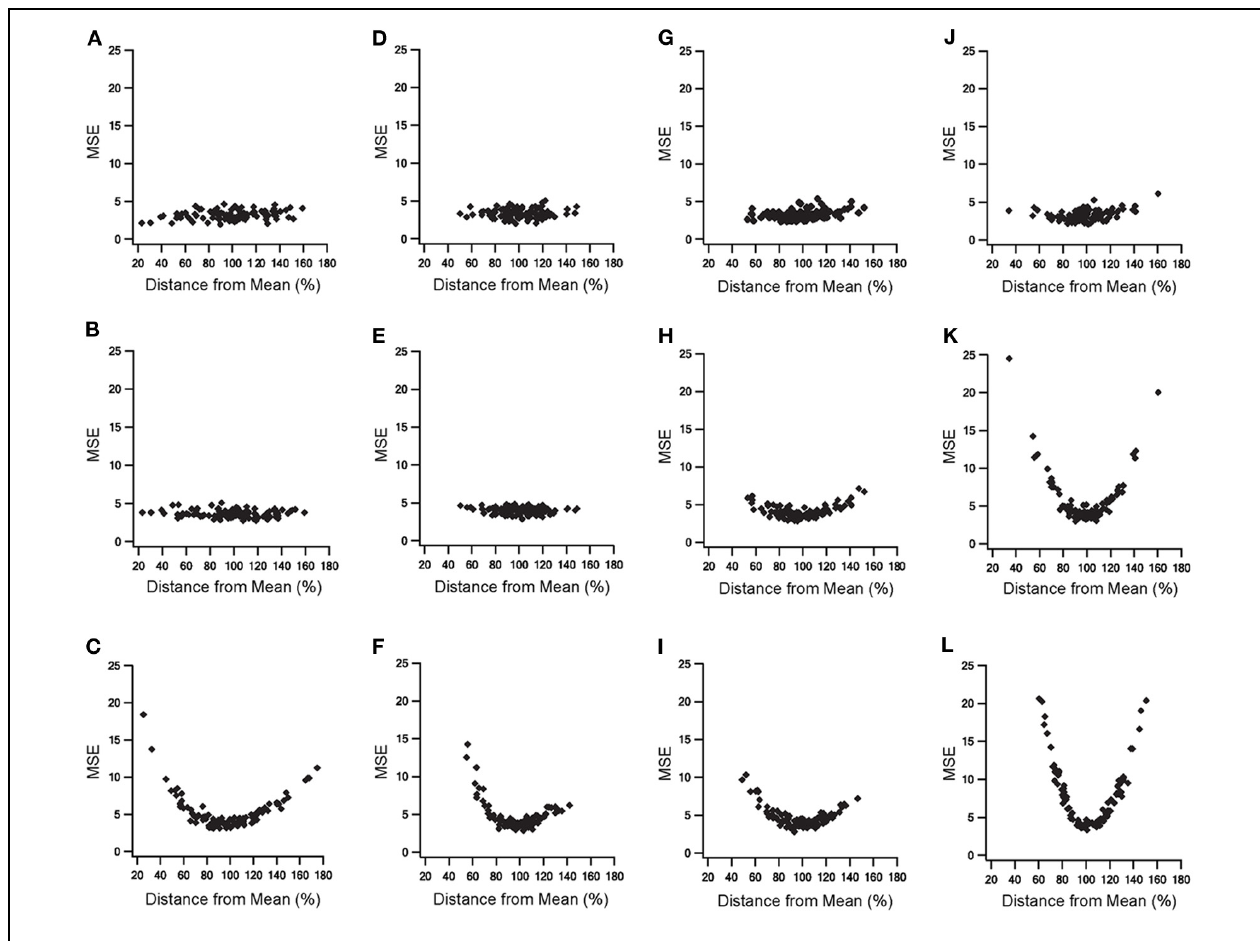
(D–F) , effects of changes in rate constant of decay reaction in metabotropic receptors (G–I) and effects of changing time constant of GP-GP depression (J–L) . Top row, errors during 10Hz stimulation; middle row, effects on firing rate during 10Hz stimulation; bottom row, effects on the firing rate during 40Hz